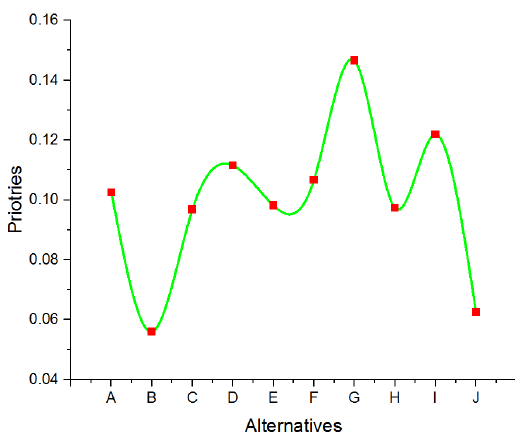
Figure 6. Comparison of Alternatives.